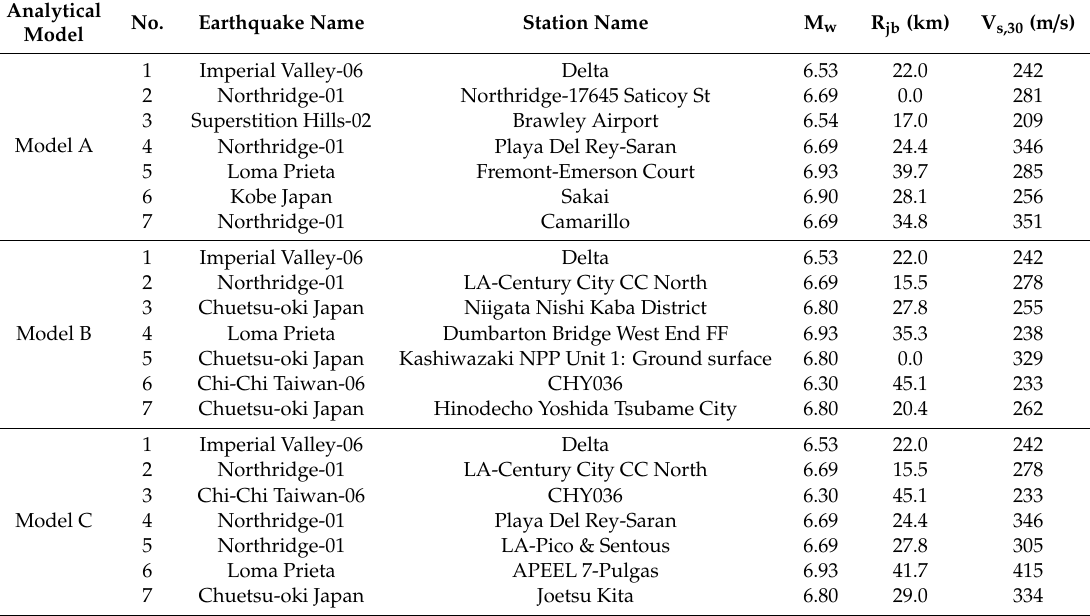
Figure 3. Target response spectra and average response spectra by seven pairs of ground motion scaling (Site class: S 4 , maximum considered earthquake (MCE), Model B). Table 2. List of ground motion used in seismic